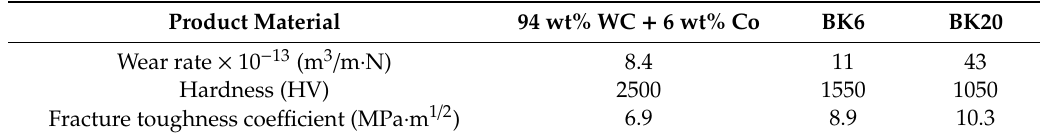
Table 2. The value of the wear rate for